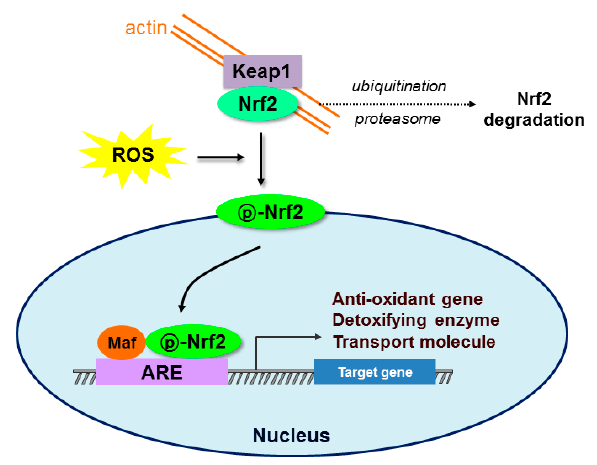
Figure 1. Schematic diagram of the Nrf2-Keap1-ARE signaling pathway. Under normal conditions, nuclear erythroid-2 like factor-2 (Nrf2) is constantly ubiquitinated through Kelch-like ECH-associated protein1 (Keap1) and degraded in the proteasome. After exposure to oxidative stress (ROS), Keap1 is inactivated and Nrf2 becomes phosphorylated. Phosphorylated Nrf2 (p-Nrf2) accumulates in the nucleus and binds to antioxidant response element (ARE) sites, subsequently activating many genes including antioxidants, detoxifying enzymes, and transport molecules.